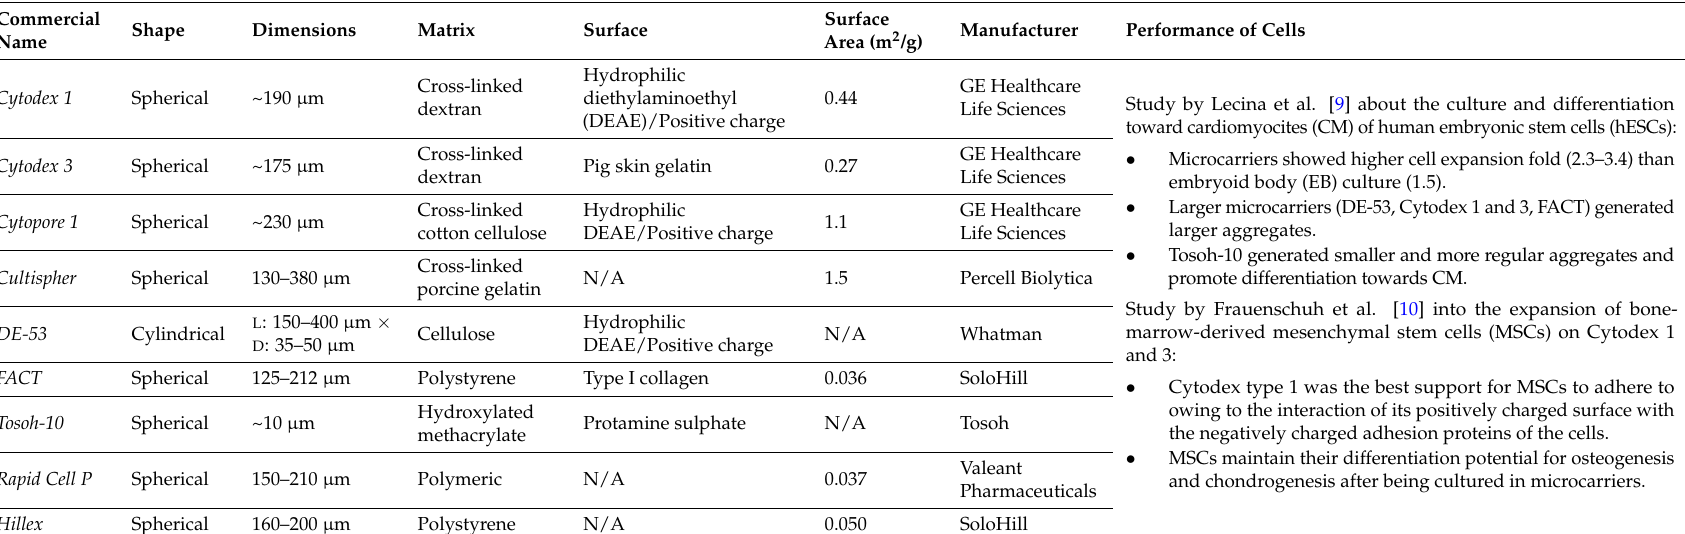
Table 1. Some of the commercially available